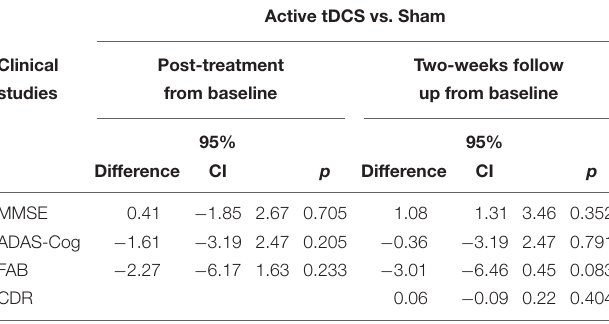
TABLE 2 | The differences in adjusted means between groups for each cognitive scale in the MMRM analysis. Active tDCS vs. Sham